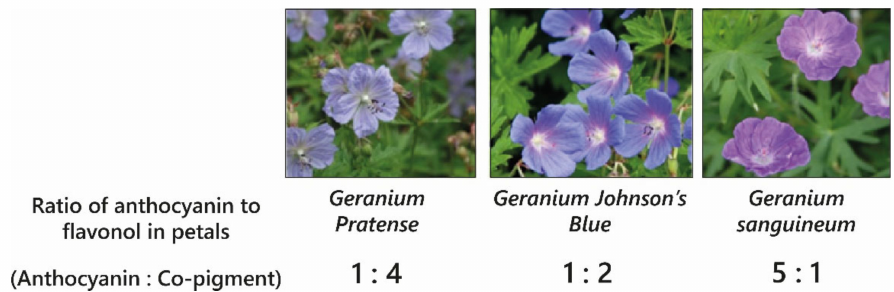
Figure 7. The different colours of varieties of cranesbill are determined by intermolecular co-pigmentation between malvidin 3- O -glucoside-5- O -(6- O -acetylglucoside) and varying relative amounts of flavonol co-pigments kaempferol and myricetin 3- O- glucoside and 3- O -sophoroside